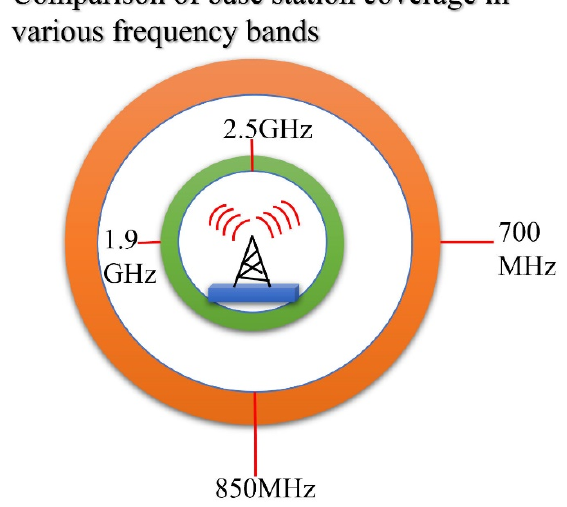
Figure 6. Coverage of cells in different mobile communication frequency bands.